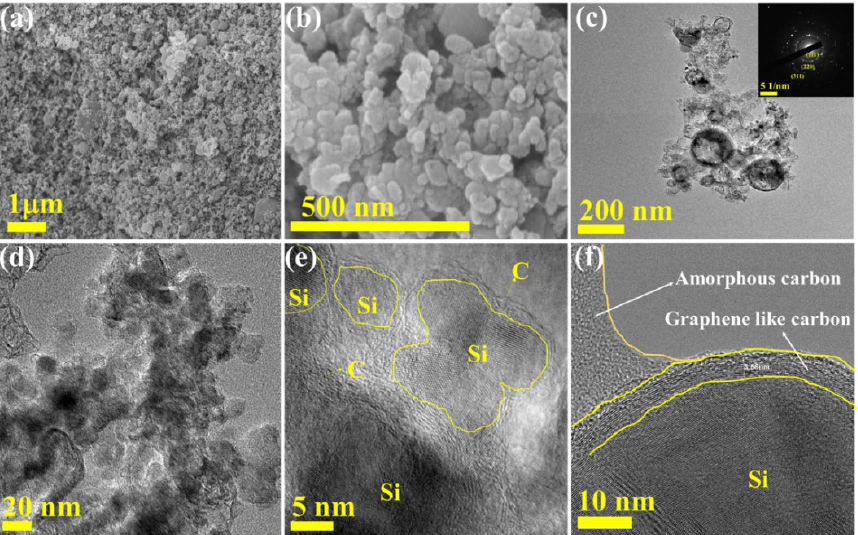
Figure 6. ( a , b ) SEM images of M-Si with different magnifications. ( c – f ) TEM images of M-Si with different magnitude. Inset in ( c ) is SAED of M-Si.